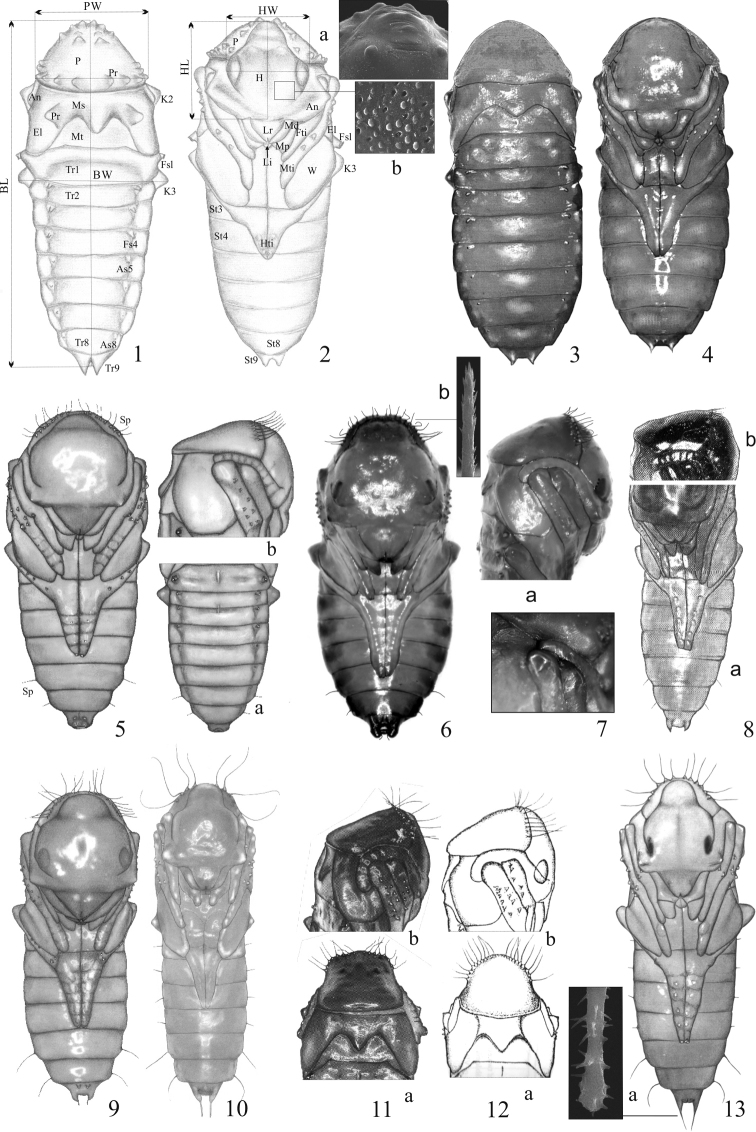
Pupae; dorsal aspect (1, 3), ventral aspect (2, 4, 5, 6, 9, 10, 13), lower part in dorsal aspect (5a), lower part in ventral aspect (8a), upper part in dorsal aspect (11a, 12a), upper part in lateral aspect (5b, 6a, 11b, 12b), cuticular projection (2a, 6b, 13a), microstructure of the head (2b) 1–2bAcylophorus
wagenschieberi3, 4Astrapaeus
ulmi5–5bOntholestes
murinus6–6bStaphylinus
erythropterus7Creophilus
maxillosus, tibiae I and II and antenna 8a, bOcypus
fulvipennis9Tasgius
melanarius10Neobisnius
villosulus11a, bPhilonthus
decorus12a, bP.
succicola13, 13aRabigus
tenuis. Abbreviations: An antenna, As atrophied spiracle, BL body length, BW body width, El elytra, Fs functional spiracle, Fti fore tibia, H head, HL head length, Hti hind tibia, HW head width, K knee, Li labium, Lr labrum, Md mandible, Mp maxillary palp, Ms mesonotum, Mt metanotum, Mti mid tibia, P pronotum, Pr protuberance, PW pronotum width, Sp setiform projection, St sternite, Tr tergite, W wing.